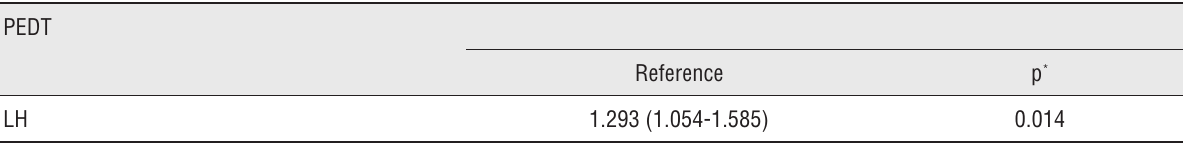
Table 2 - Multivariate model for PEDT score and LH level.